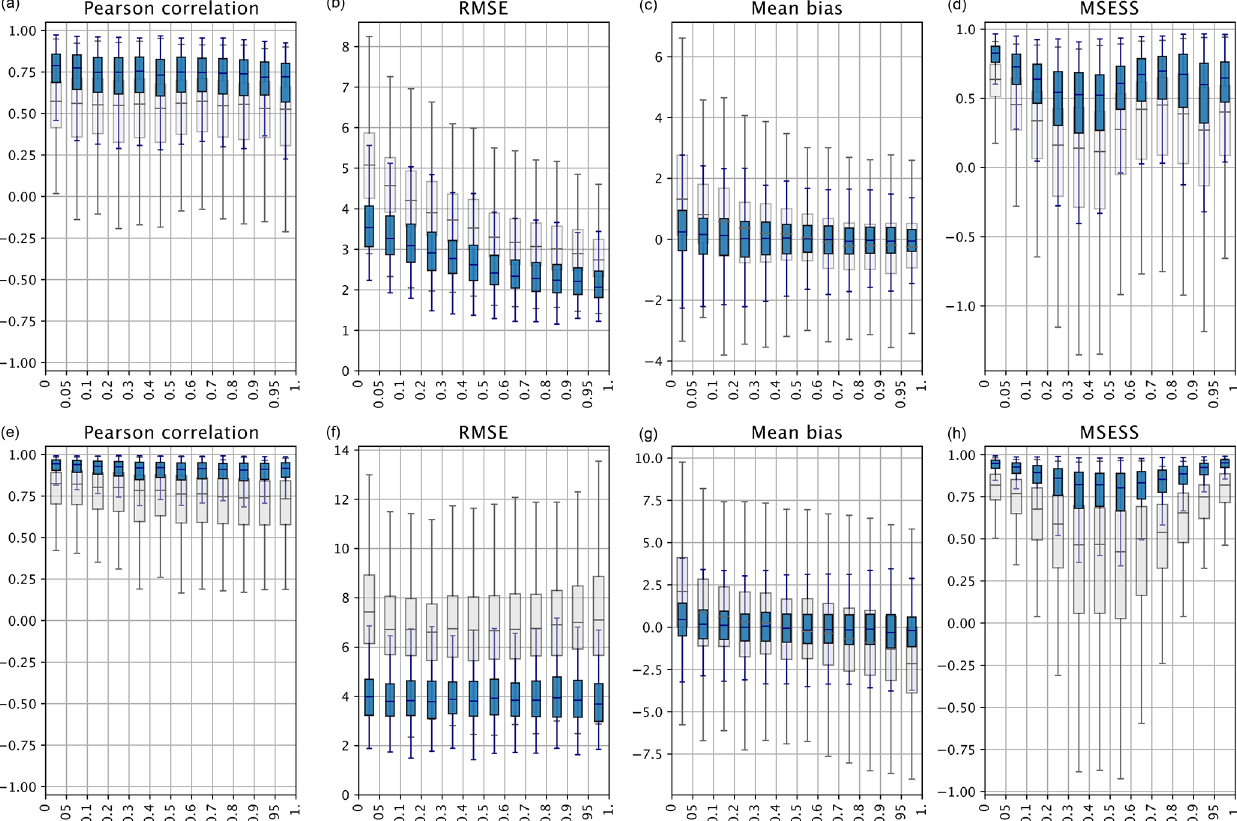
Figure 4. Validation over space by mean temperature quantiles (a–d) and SLP quantiles (e–h) for the period 1950–2020 (NDJF). Shown are the results for the ARM (gray) and the EnKF (blue) as well as their respective metrics: Pearson correlation coefficient, RMSE, mean bias, and MSESS. The boxes represent the interquartile range (75th–25th percentiles), and the whiskers extend to a distance of 1.5 × IQR outside the